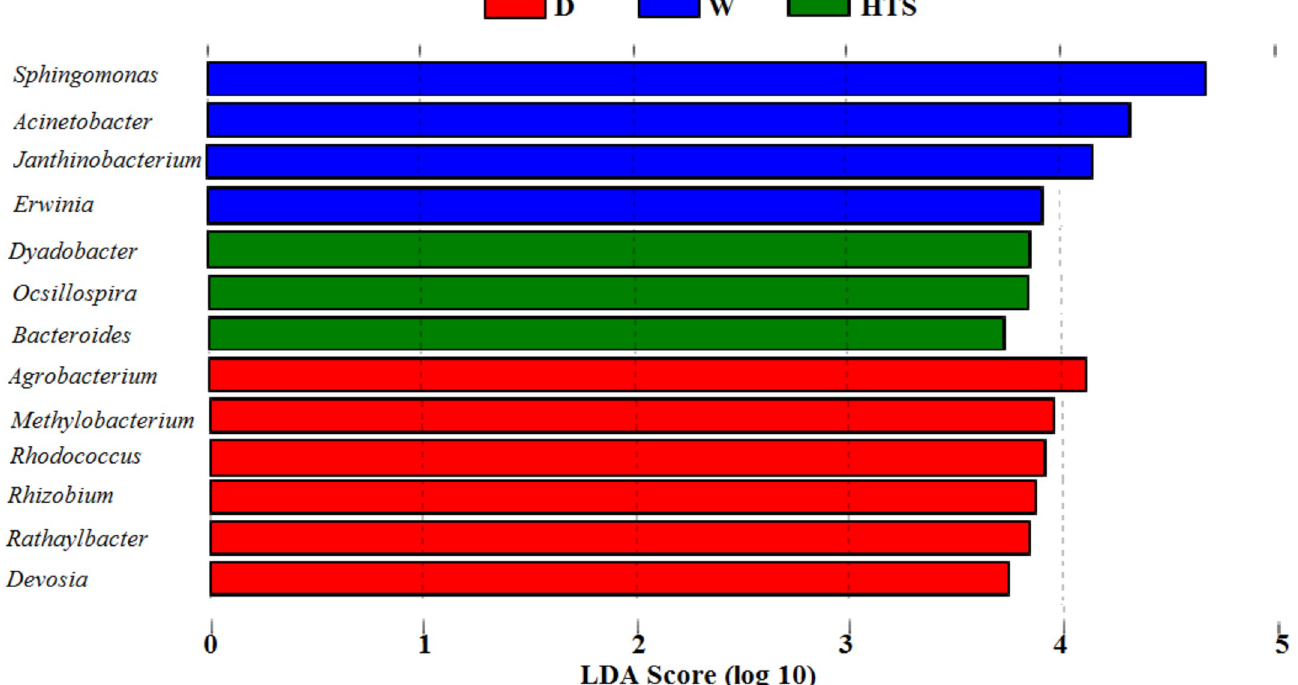
PLOS ONE | https://doi.org/10.1371/journal.pone.0242373 November17,